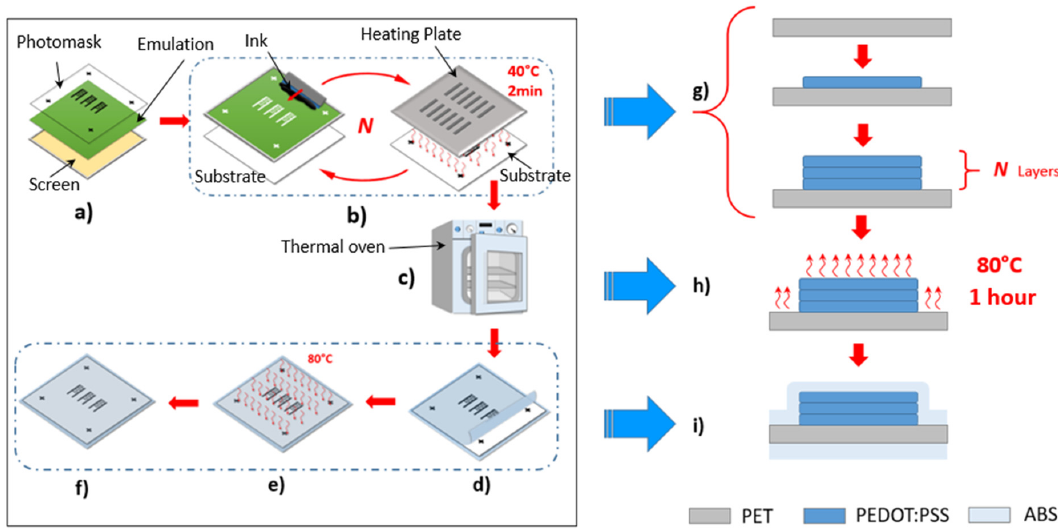
Figure 2. The workflow for multilayer screen printing: ( a ) preprocess: preparing the screen; ( b ) multilayer printing process; ( c ) curing process; ( d – f ) the coating process. The illustration of printing in cross section: ( g ) the printing process corresponding to steps ( a , b ); ( h ) the curing process corresponding to ( c ) and ( i ) the protective coating process corresponding to ( d – f ).